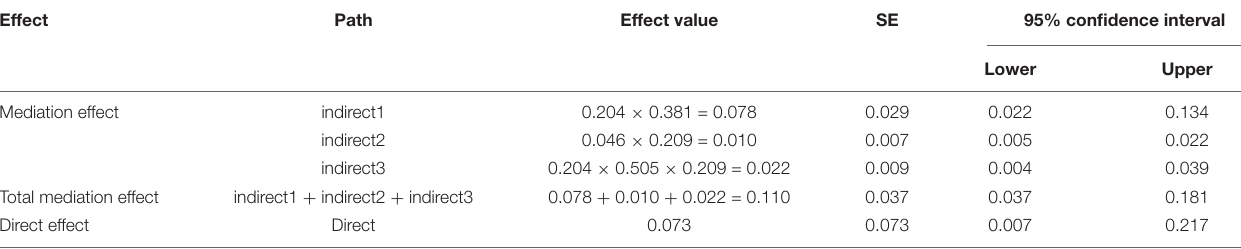
TABLE 4 | Testing the pathways of the multiple mediation